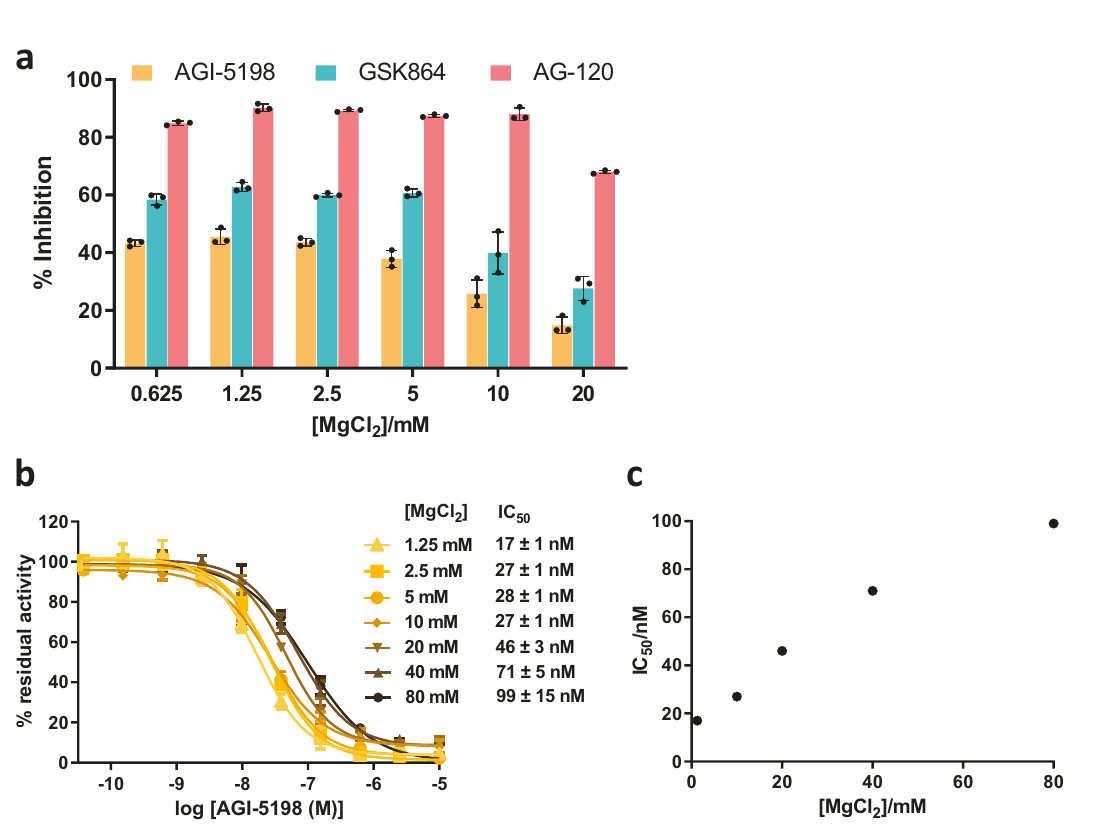
Fig. 6 Studies on R132H IDH1 inhibition with an isolated enzyme in the presence of different Mg 2 + concentrations. a The effects of different MgCl 2 concentrations on the extent of inhibition of R132H IDH1 (300 nM) by its inhibitors (100 nM), AG-120, GSK864 (different scaffold and binding stoichiometry from AG-120) and AGI-5198 (which has similar scaffold to AG-120, but which is less potent 75 ), as determined by absorbance assays. b , c IC 50 of AGI-5198 for R132H IDH1 at different MgCl 2 concentrations in the presence of 150 mM NaCl. IC 50 values of AGI-5198 for R132H IDH1 increase with increasing MgCl 2 concentrations, as determined by absorbance assays. Data are mean ± SD, n = 3 technical replicates. See ‘ Methods ’ for assay